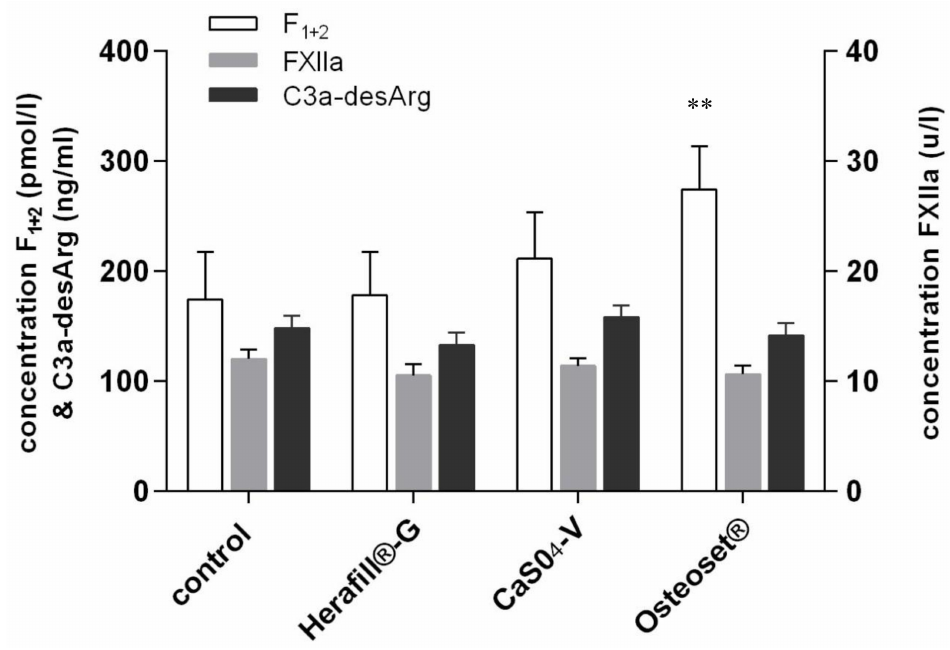
Figure 2. Coagulation markers following incubation of blood with tested beads ( n = 16). Levels of significance used were **: p <